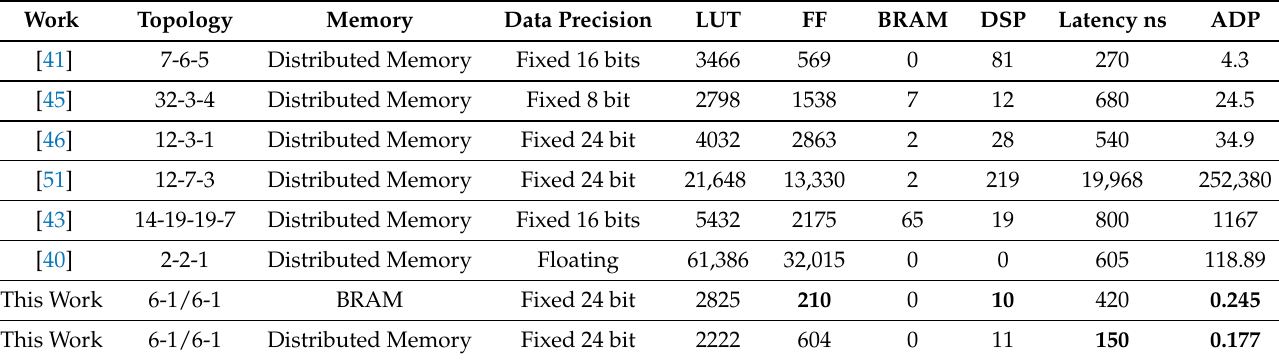
Table 3. ONN with HBP comparison with